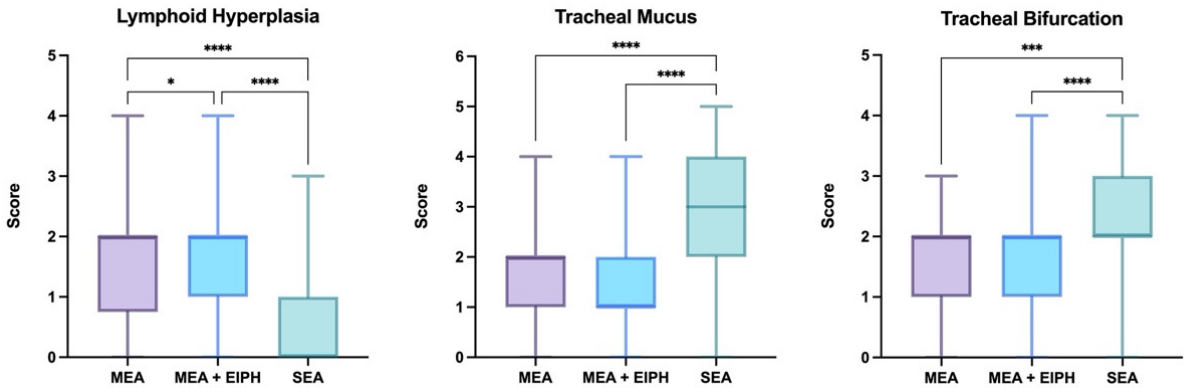
Figure 2. Box plot showing endoscopic scores of pharyngeal lymphoid hyperplasia, tracheal mucus and tracheal bifurcation in the SEA, MEA and MEA + EIPH groups. The statistical significance is shown as * ( p < 0.05), *** ( p < 0.001), **** ( p < 0.0001).